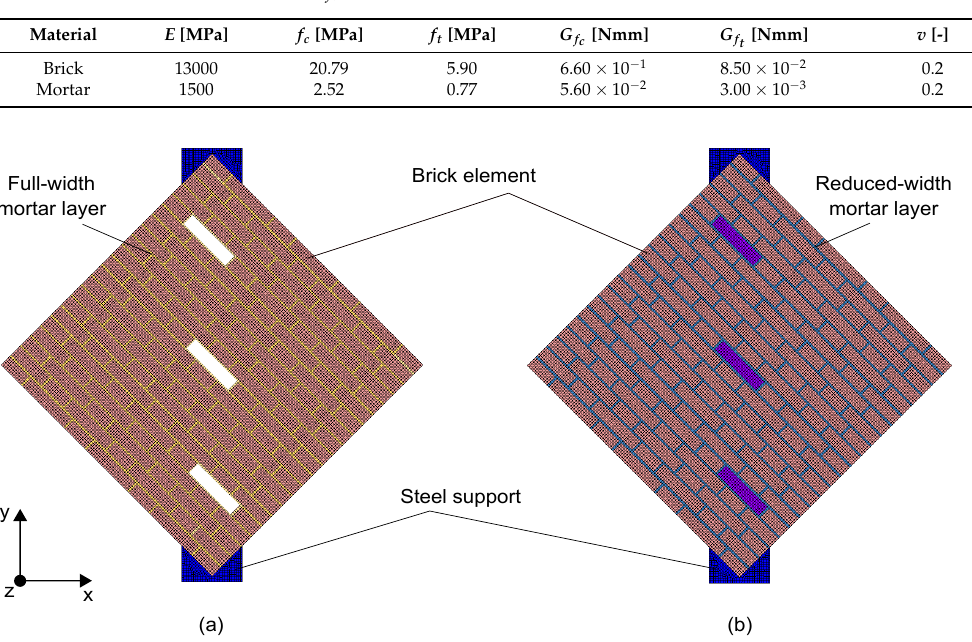
Figure 3. Numerical models: ( a ) Specimen A with intact mortar layers; ( b ) Specimen B with degraded mortar layers.